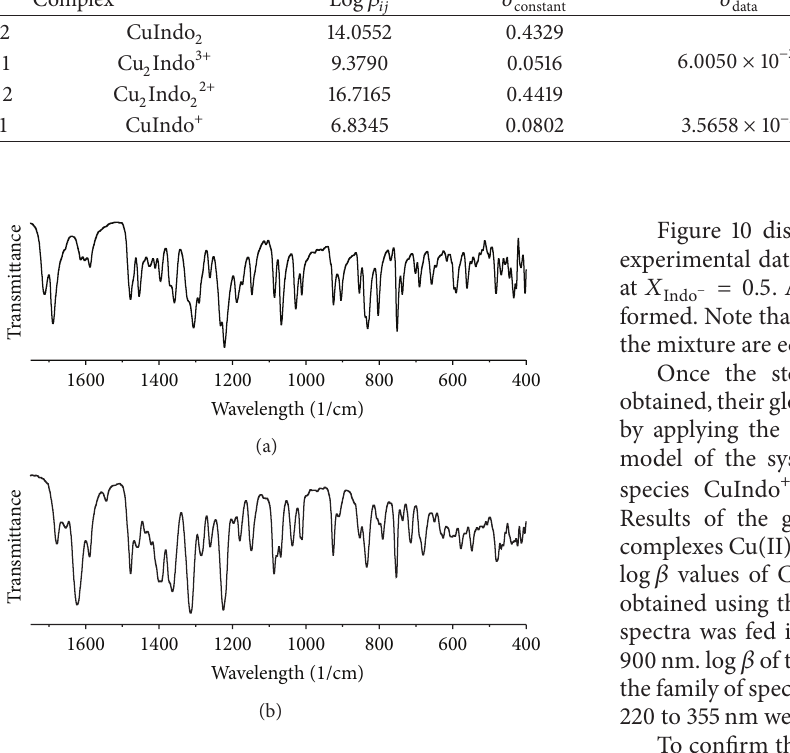
Figure 6: Solid state IR spectra of (a) Indomethacin and (b) the precipitate in the stoichiometry 2 : 4 (Cu 2 Indo 4